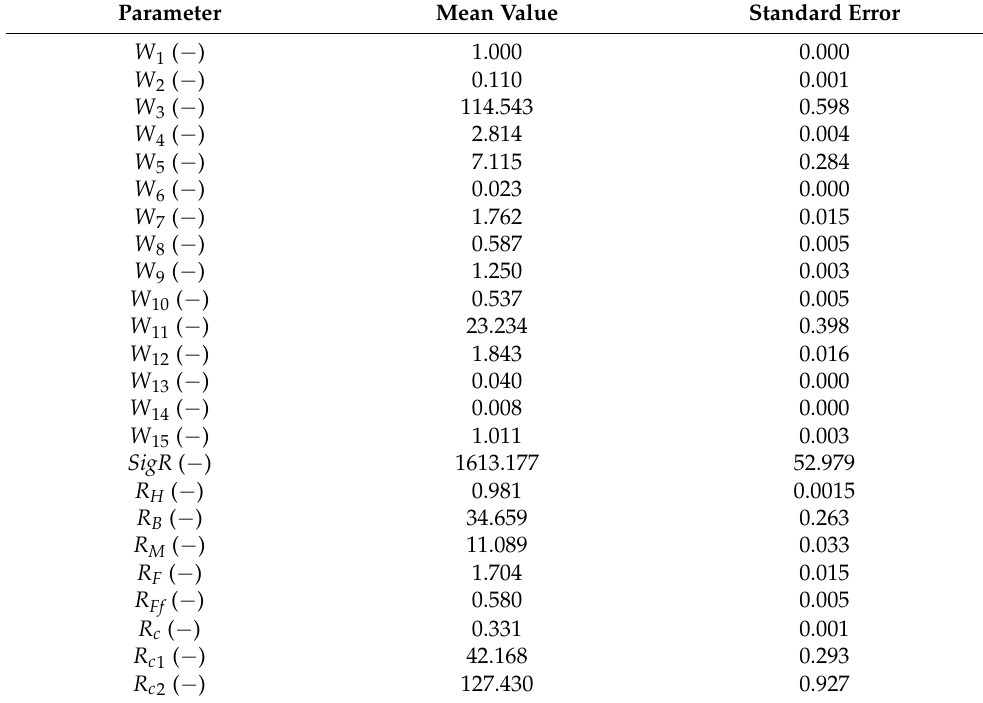
Table 3. Mean values of selected shape factors of ‘Mejhoul’ date fruit.